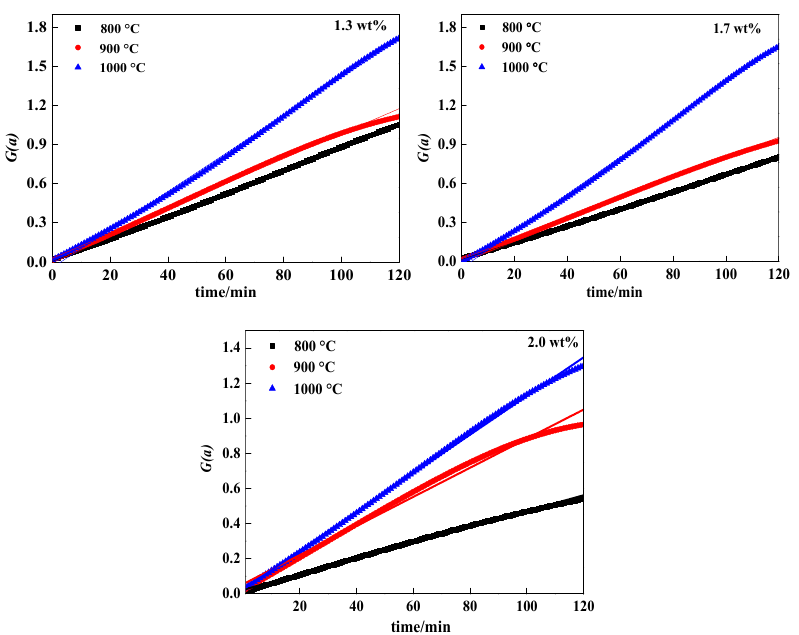
Figure 12. Plot of G(a) vs time for sinters with different MgO content. Table 5. Rate constant and degree of fitting.